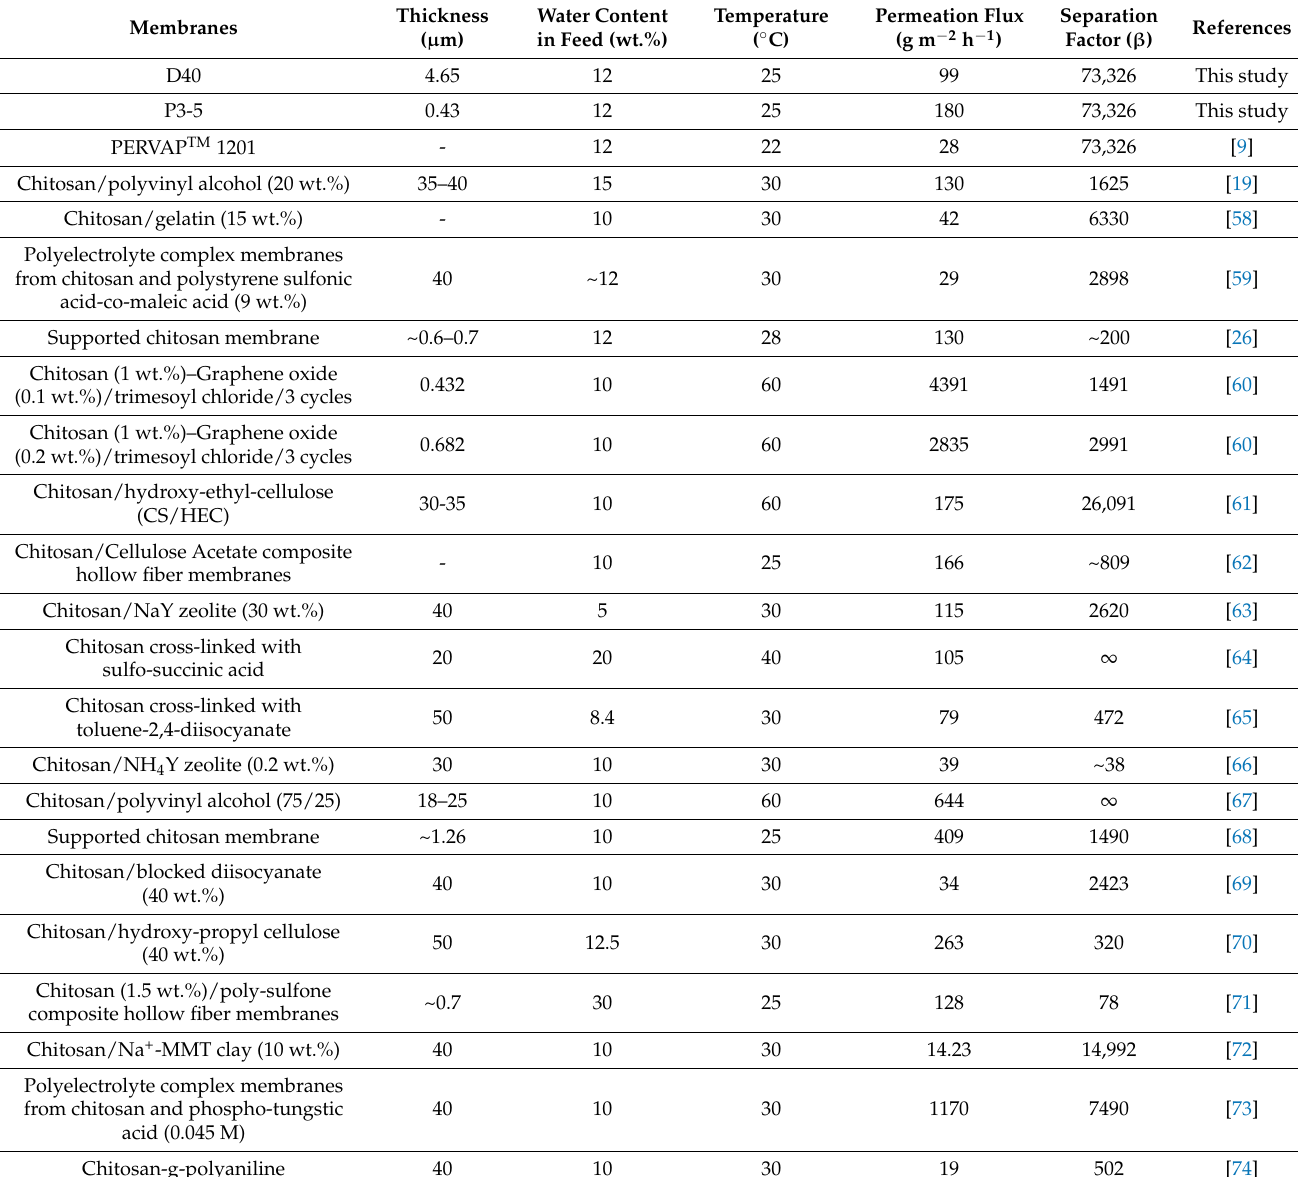
Table 7. Comparison of the transport properties of D40 and P3-5 TFN membranes for isopropanol dehydration by